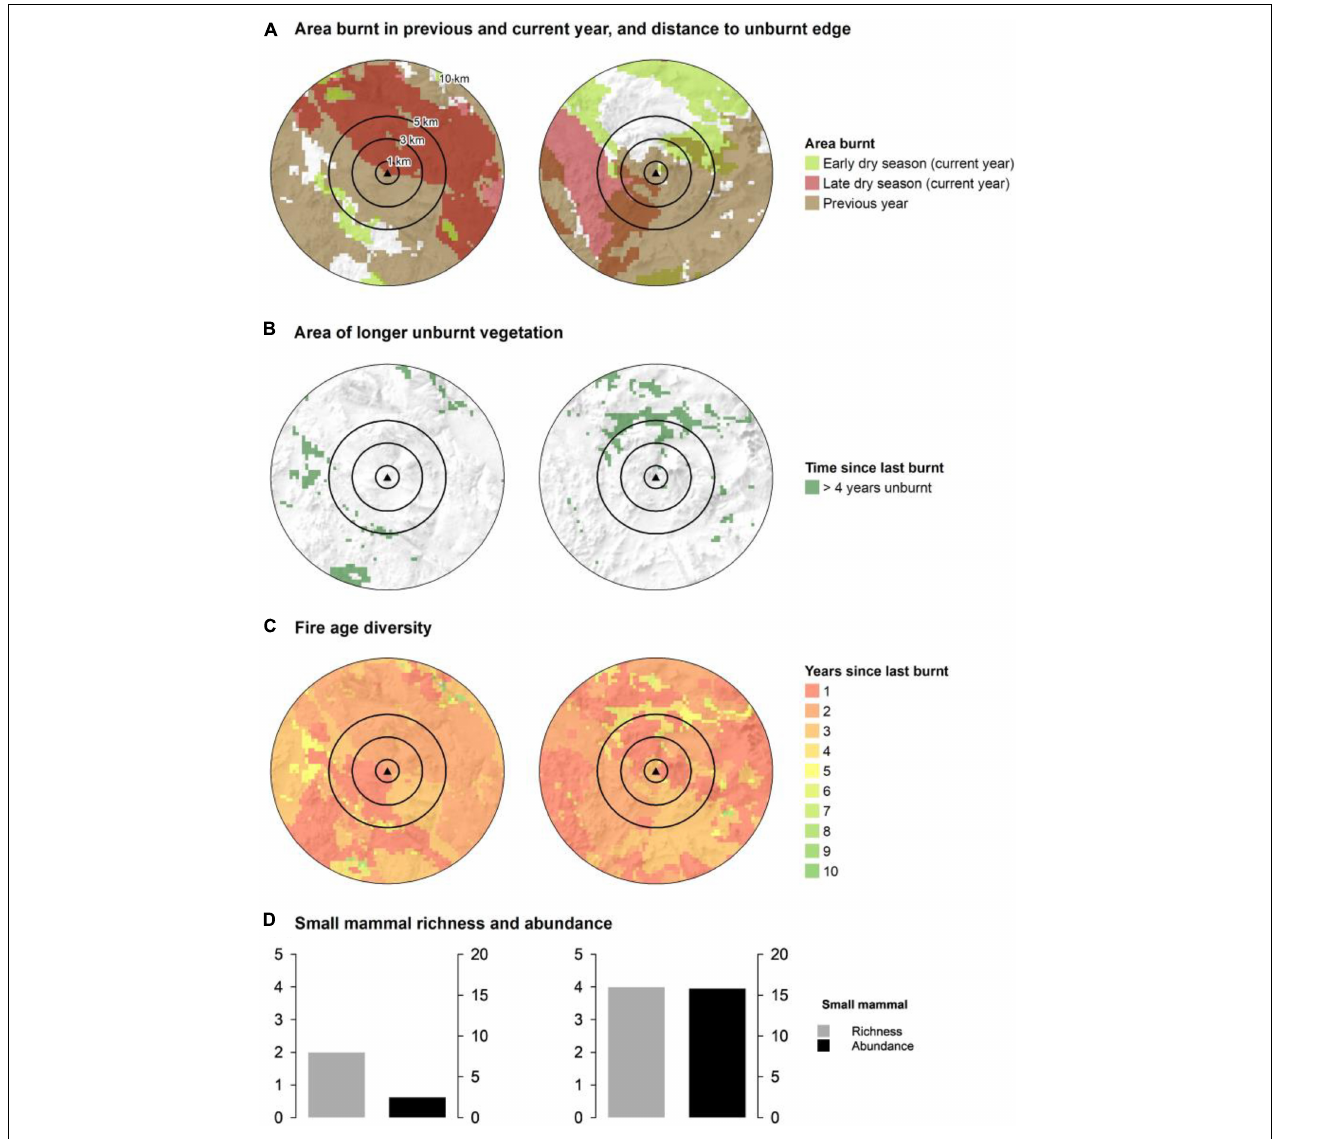
FIGURE 2 | Fire mosaic elements within the landscape context of two of the mammal survey sites, LCI 205 at Inglis Gap (left) and LCI 210 at Mt Hart (right). The graphs show concentric spatial areas around sites defined by rings at 1, 3, 5, and 10 km from the center of the location of the survey site and provides a partial view of the fire mosaic context within which these sites are placed. (A) Shows the spatial extent of early (March–July) and late dry season fires (August–December) during the year of the survey and the total extent of fire in the previous year. (B) Shows the spatial extent of habitat unburnt for four or more years. (C) Shows the patterns of ‘pyrodiversity,’ here defined as the number of post-fire habitat ages, within the landscape context of the survey sites. (D) Shows a histogram of mammal abundance (black; number of individuals per 100 trap nights) and richness (grey; number of different species) for the two sites, with the Mt Hart site LCI 210 supporting much greater mammal abundance and richness (right) than the Inglis Gap site LCI 205